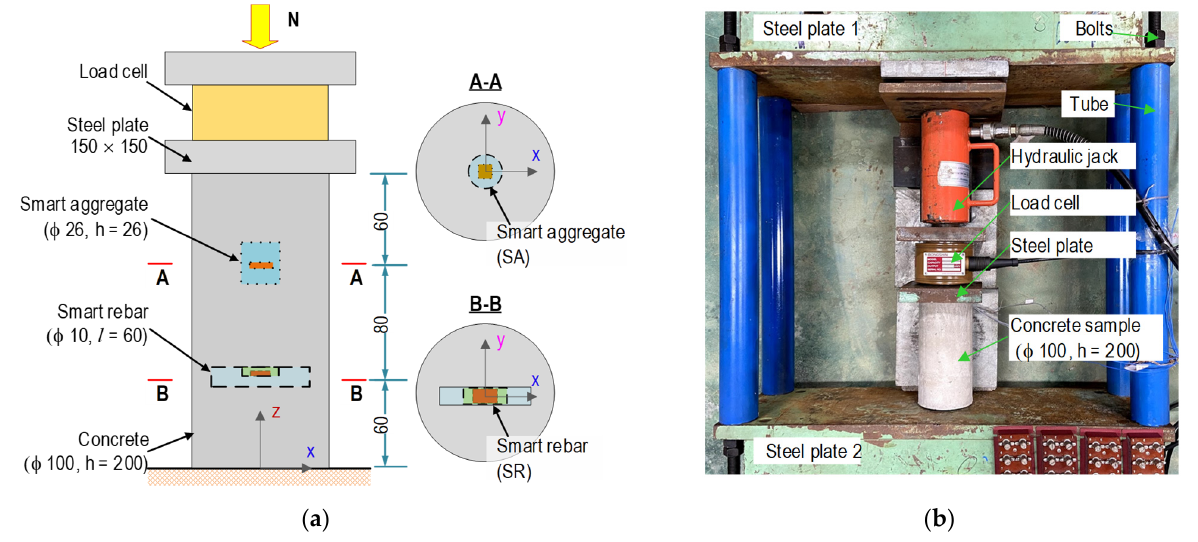
PZT-embedded smart rebar (SR); ( b ) PZT-embedded smart aggregate (SA).